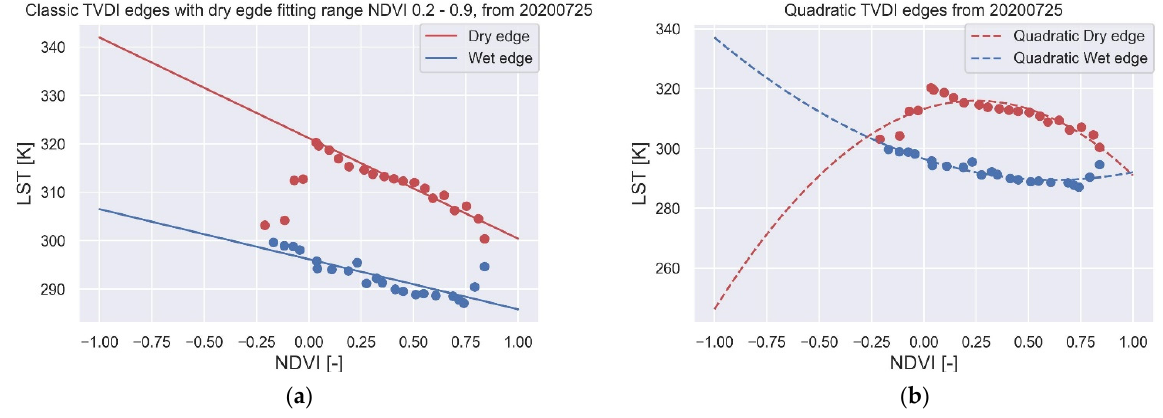
Figure 3. Dry and wet edge fitting for both classic ( a ) and quadratic ( b ) TVDI for 25 July 2020 for the whole research area.